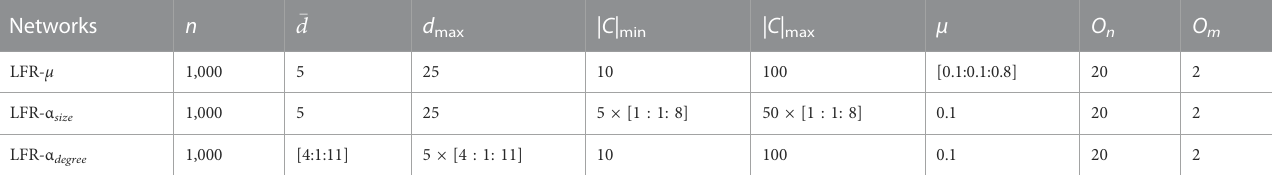
TABLE 2 The parameter settings of LFR benchmark networks.